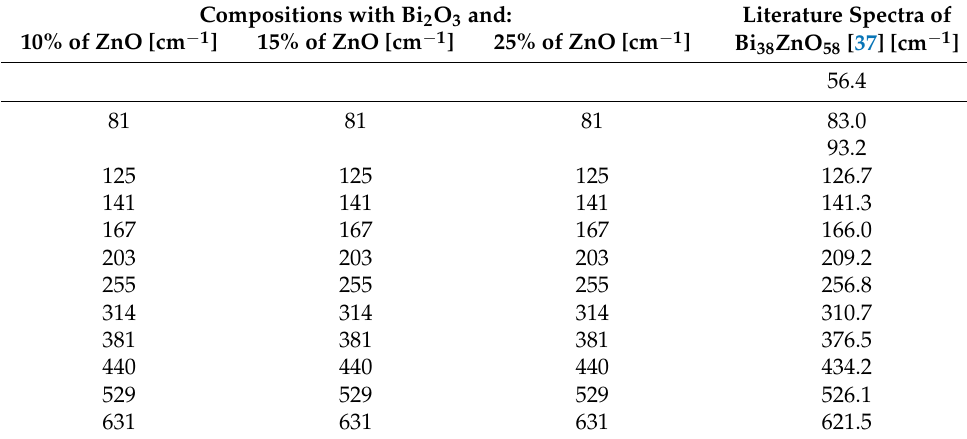
Table 2. Peak positions from Raman spectra of coated alumina samples with the literature values. Compositions with Bi 2 O 3